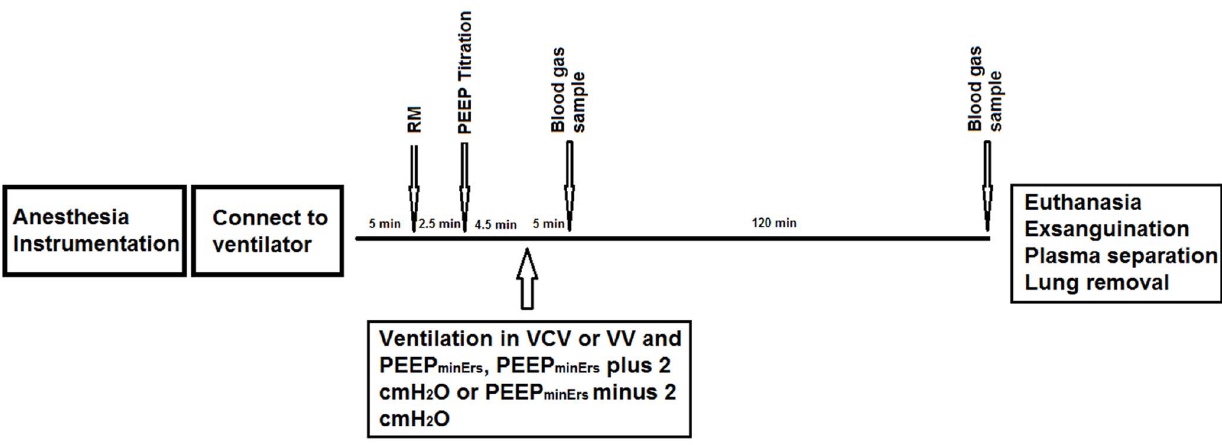
Figure 1. Time course of respiratory system elastance and slope. A. Respiratory system elastance (Ers) throughout ventilation protocols. Red points are minute-averaged values of Ers and its fitted line (blue line). B. Slope of Ers calculated by angular coefficient of the groups: VCV_E (volume- controlled mode and PEEP minErs ; n=6), VCV_E + 2 (volume-controlled mode and PEEP minErs plus 2 cmH 2 O; n=6), VCV_E-2 (volume-controlled mode and PEEP minErs minus 2 cmH 2 O; n=6), VV_E (variable ventilation and PEEP minErs ; n=6), VV_E + 2 (variable ventilation and PEEP minErs plus 2 cmH 2 O; n=5), VV_E-2 (variable ventilation and PEEP minErs minus 2 cmH 2 O; n=6). Effect of ventilator mode, PEEP and interaction were tested with two-way ANOVA followed by Tukey post-hoc. Time effect was tested by generalized linear model. Statistical significance was accepted at p , 0.05. *p , 0.05.